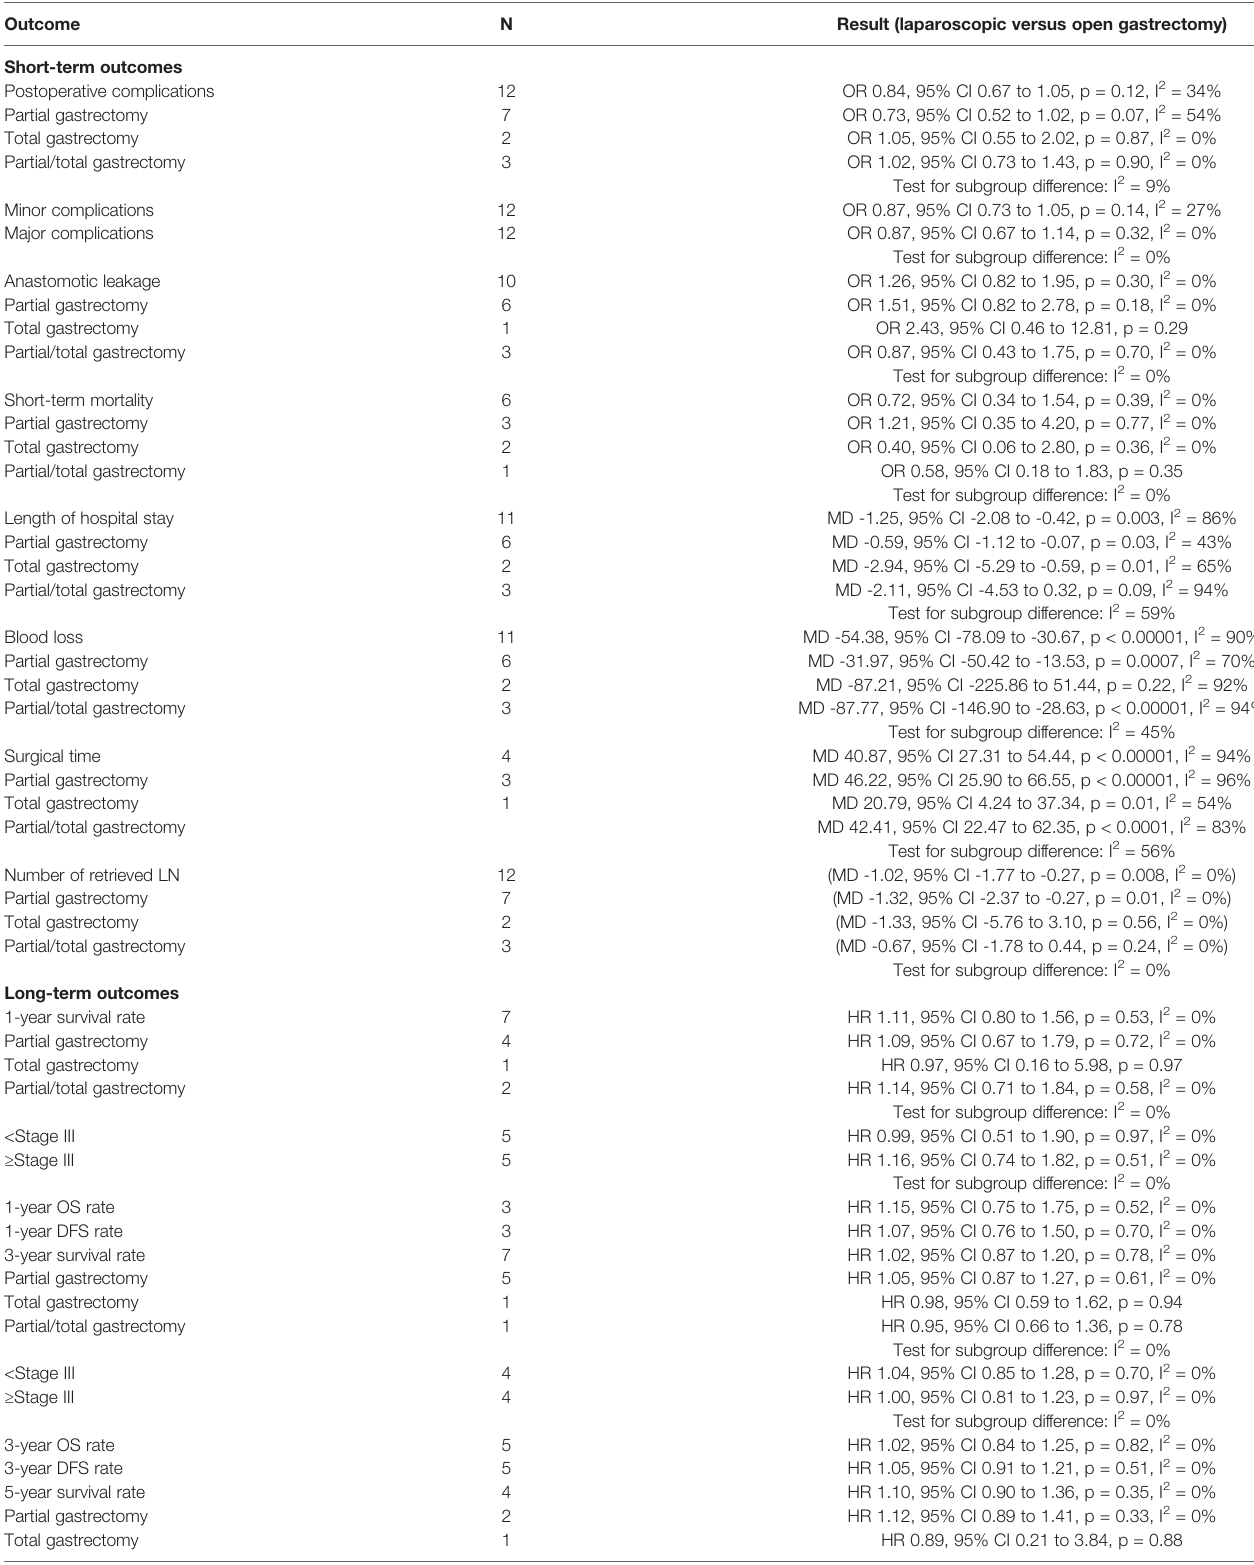
TABLE 2 | Results of this meta-analysis. Outcome N Result (laparoscopic versus open